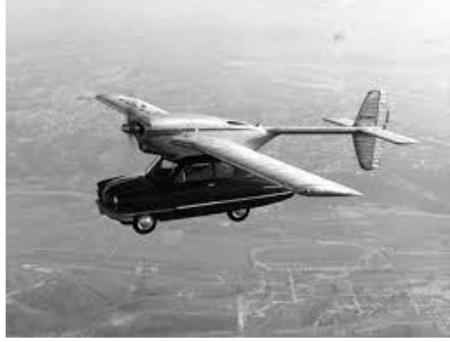
Figure 4. Convair Model 118 ConvAirCar